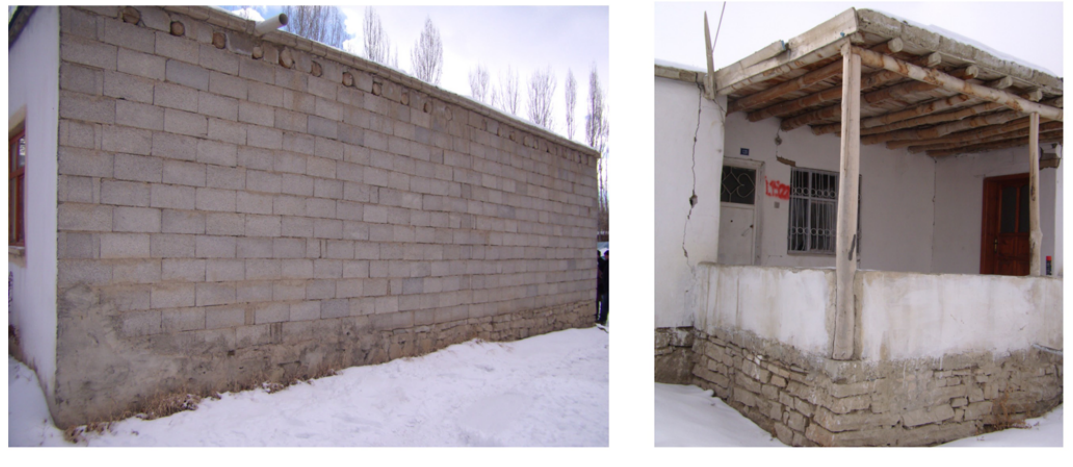
Fig. 12. Outside views of a traditional roof